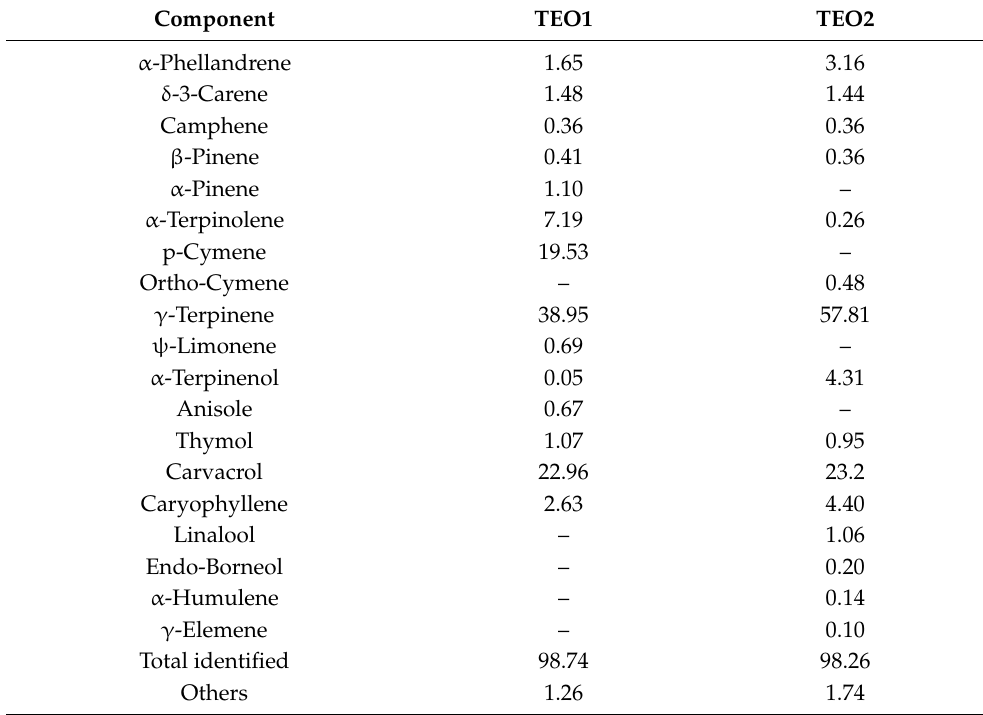
Table 1. Chemical composition of Thymbra essential oils.